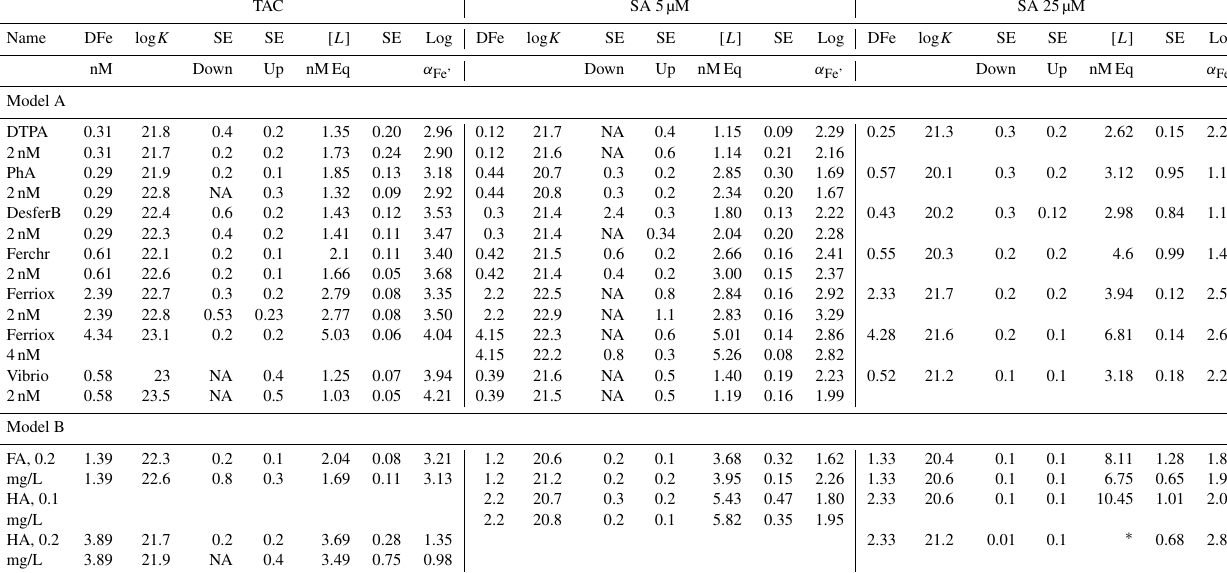
Table 2. Results of the titrations following the three applications, SA5, SA25 and TAC for model A ligands, with a well-described compo- sition and a specific added concentration of 2 or 4nM, and for model B ligand, the humic substances FA and HA that do not have a fixed composition and were added in weight units (0.1–0.4mg/L). DFe was measured by ICPMS. log K is used for log K cond with respect to Fe 3 + . log K cond and [ L ] are calculated using the non-linear Langmuir isotherm. Alpha ( K cond ×[ L (cid:48) ] ) is calculated using [ L (cid:48) ] and not by simple [ L ] minus DFe. DFe is in nM, [ L ] is in nMEqFe and K cond in M − 1 . For the model ligands 2nM were used unless otherwise stated. Most model ligands have been analyzed in duplicate with TAC and SA5, and once with SA25. The addition of the humics was determined using Laglera and van den Berg (2009) for HA and Sukekava et al. (2018) for FA. Since K (cid:48) is log transformed, the standard error (SE) is asymmetric to lower and upper values; therefore two SE values are obtained, one to lower (down) and to upper (up) values. TAC SA 5µM SA